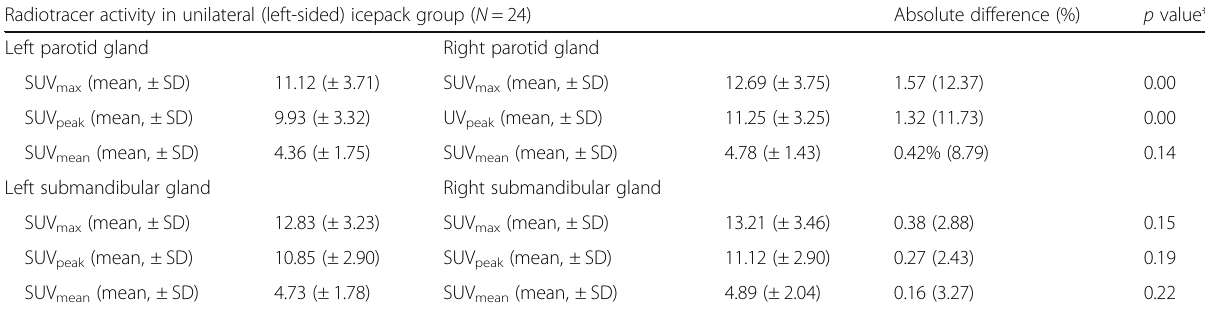
Table 4 Radiotracer activity in salivary glands of unilateral icepack group: (cooled) left side versus (non-cooled) right side Radiotracer activity in unilateral (left-sided) icepack group ( N = 24) Absolute difference (%) p value* Left parotid